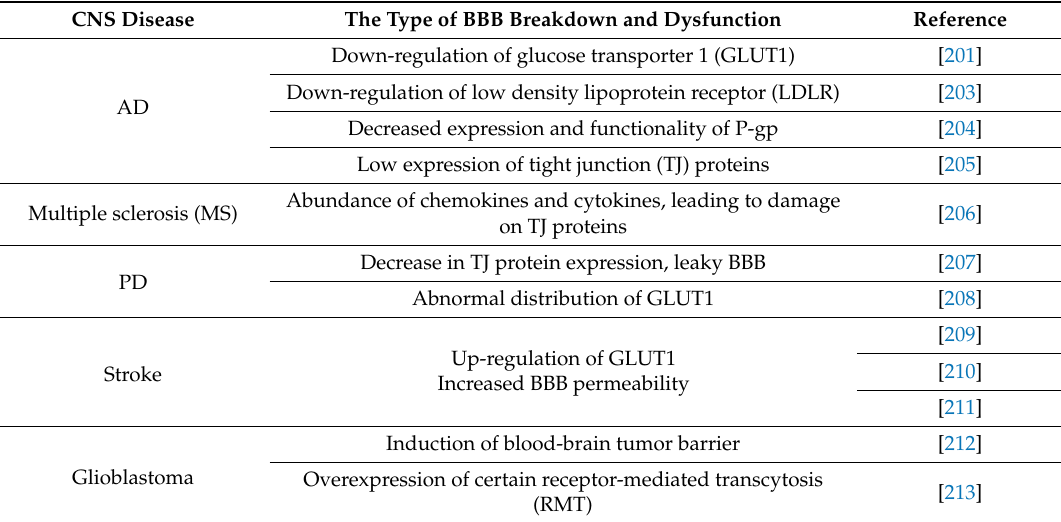
Table 3. Blood-brain barrier (BBB) breakdown and dysfunction in pathological